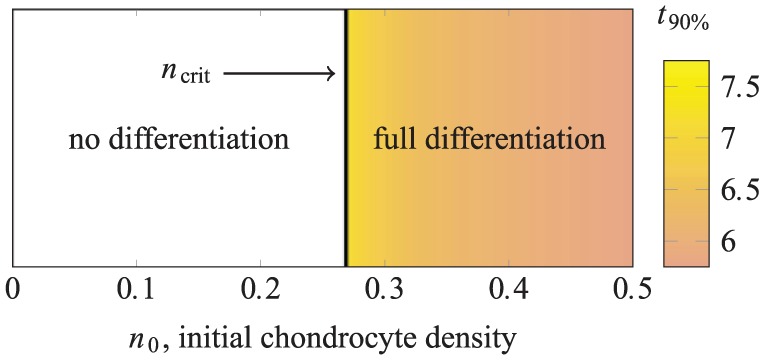
The final yield of chondrocytes in the lower layer for case study 1 as n0, the initial density of chondrocytes in the upper layer, is varied. The vertical line indicates ncrit, the critical value of initial chondrocyte density above which the constitutive production of TGF-β by the seeded chondrocytes is sufficient to induce differentiation of all MSCs in the lower layer. The full differentiation region is shaded to indicate t90%, the time after which 90% of the seeded MSCs have differentiated into chondrocytes.